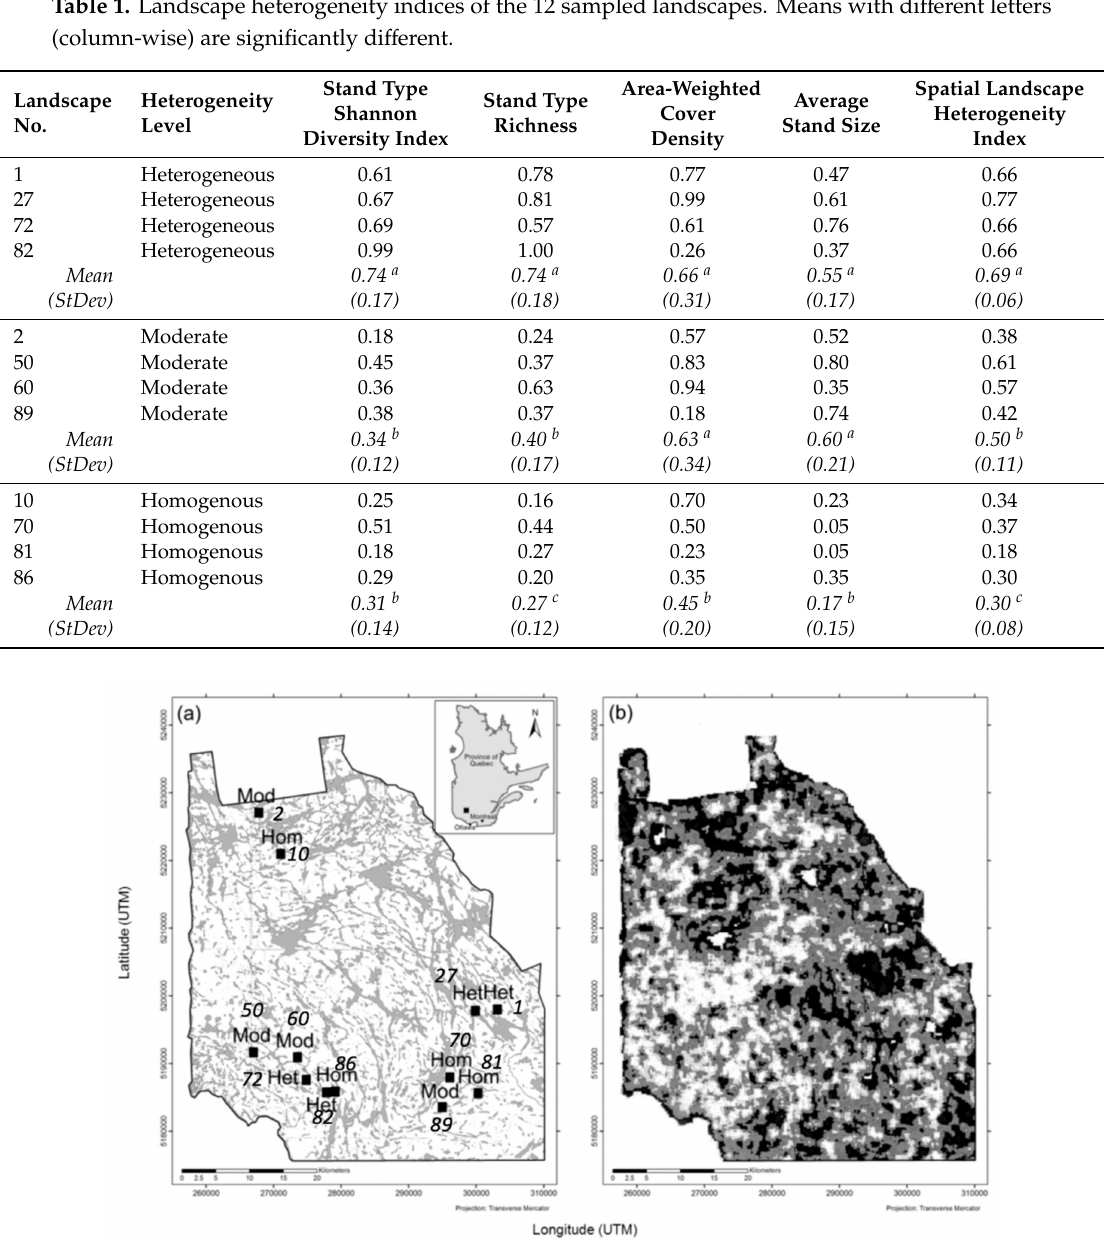
Figure 1. Geographical position of the 12 sample landscapes ( a ) (grey areas are waterbodies and waterways; italicised numbers represent landscape identifier) and map of the spatial landscape heterogeneity index ( b ) (heterogeneous: white; moderate: grey; homogenous: